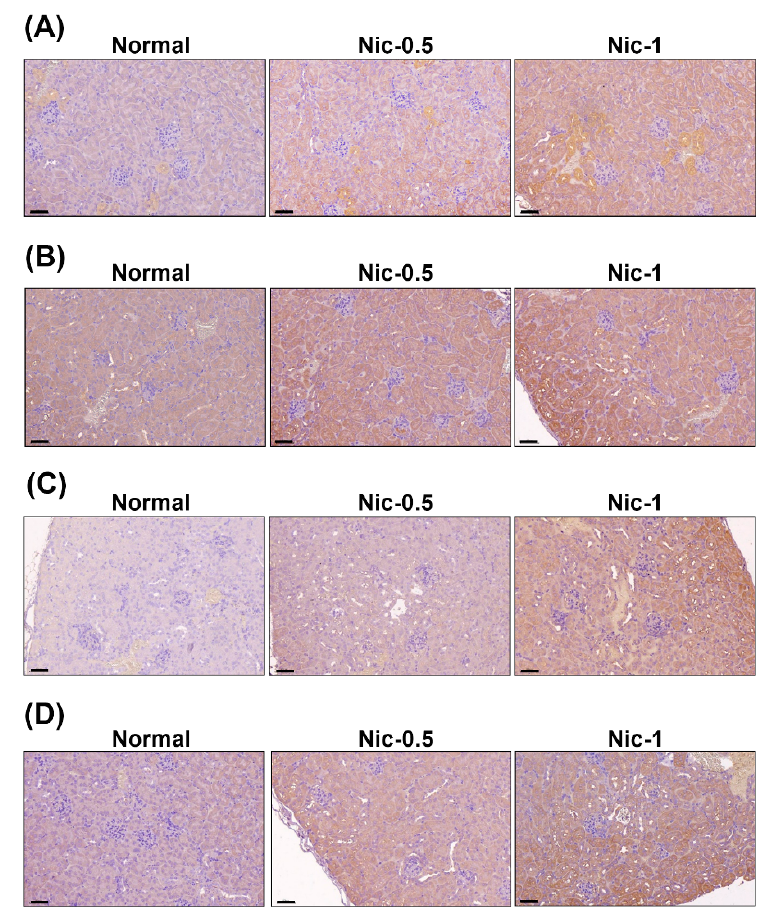
Figure 7. The protein expression of kidneys after nicotine exposure. Immunohistochemistry (IHC) was used to determine the expression levels of α 7nAChR ( A ), IRE1 α ( B ), LC3 ( C ) and NLRP6 ( D ) in kidney tissues. Scale bar = 60 μ m.